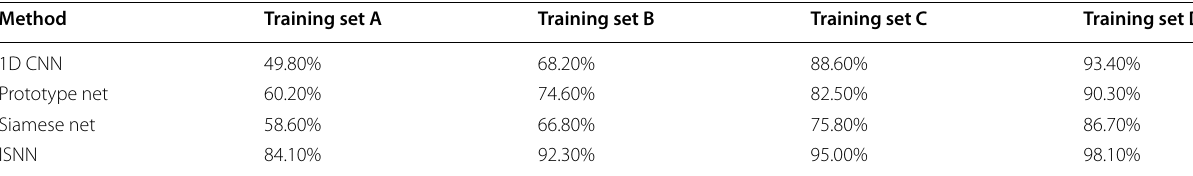
Table 5 Accuracy of various methods using Testing set